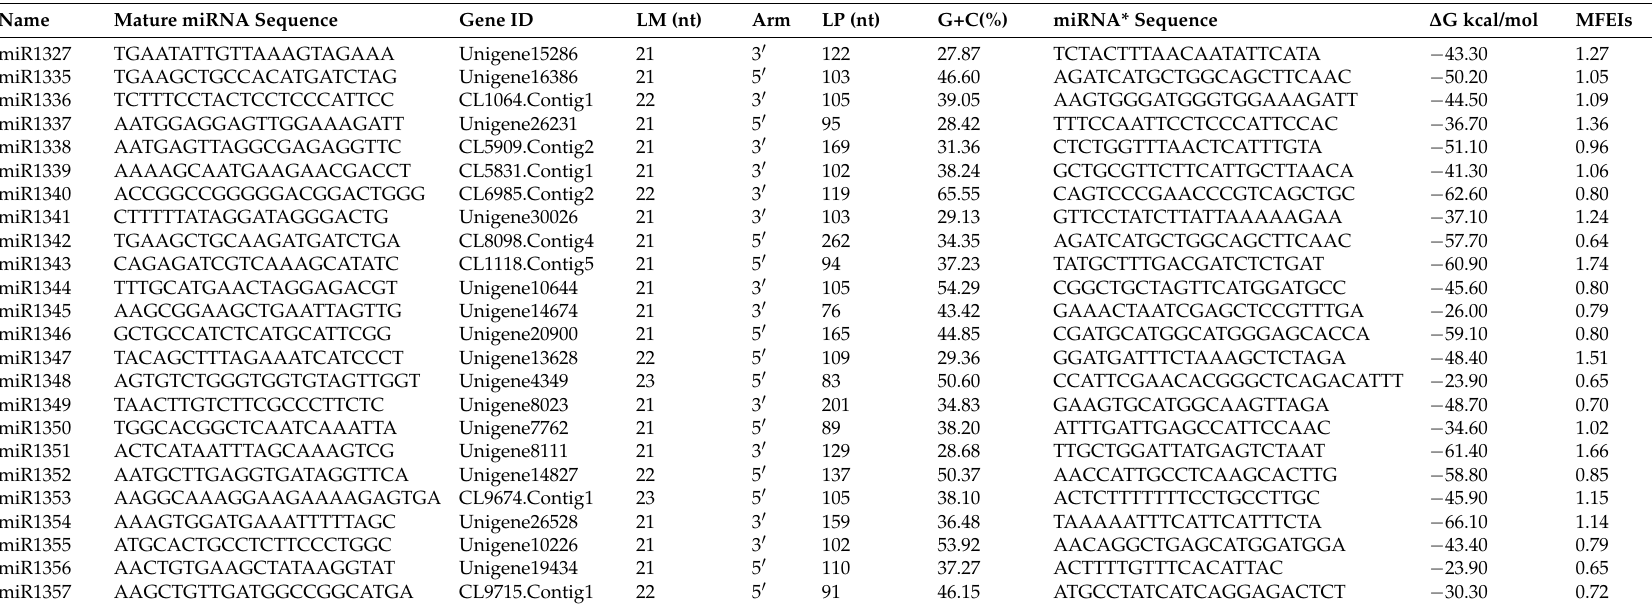
Table 2. List of the 24 novel miRNAs in